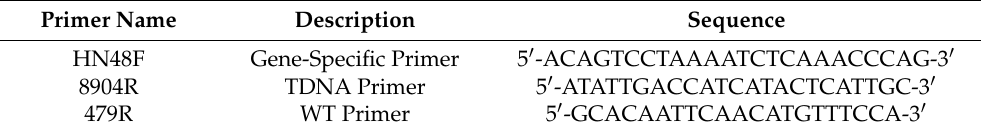
Table 1. Primers used for TDNA insertion